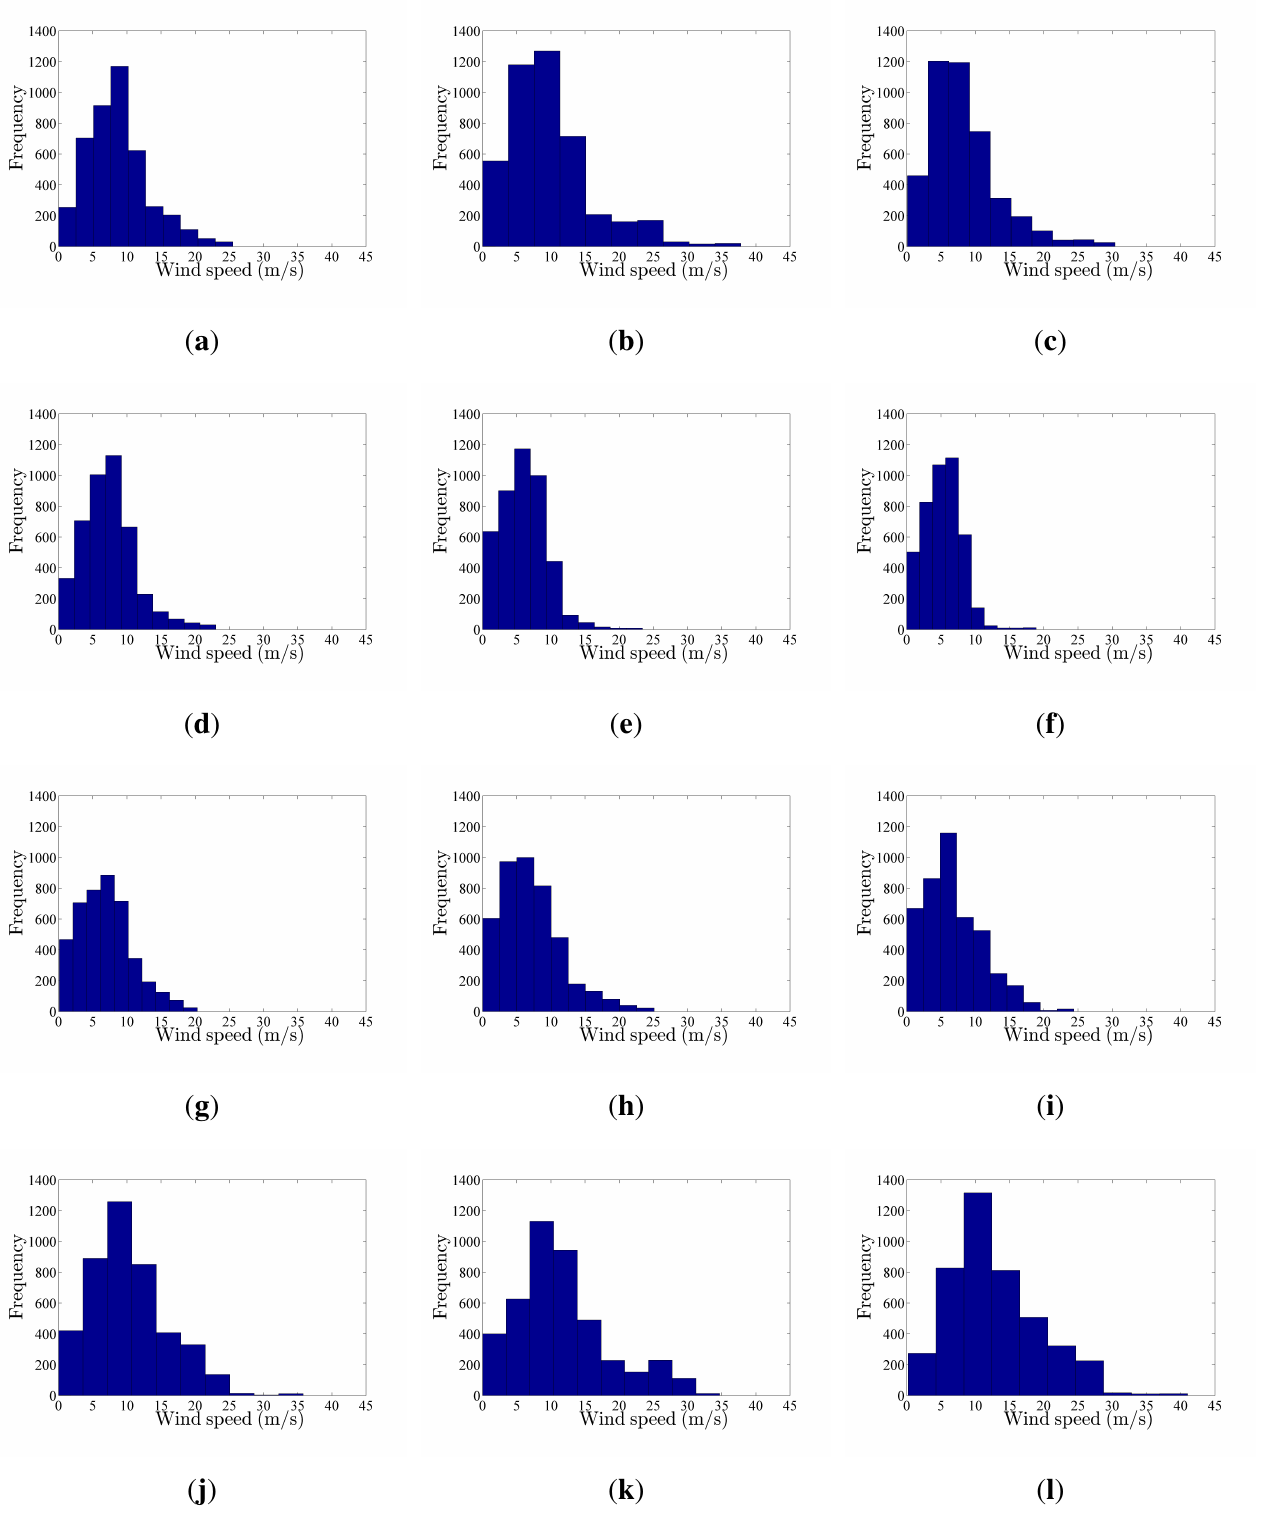
Figure 3. Histograms of wind speed data measured at a 55-m height for each month from February 2013–January 2014. ( a ) February; ( b ) March; ( c ) April; ( d ) May; ( e ) June; ( f ) July; ( g ) August; ( h ) September; ( i ) October; ( j ) November; ( k ) December; and ( l )